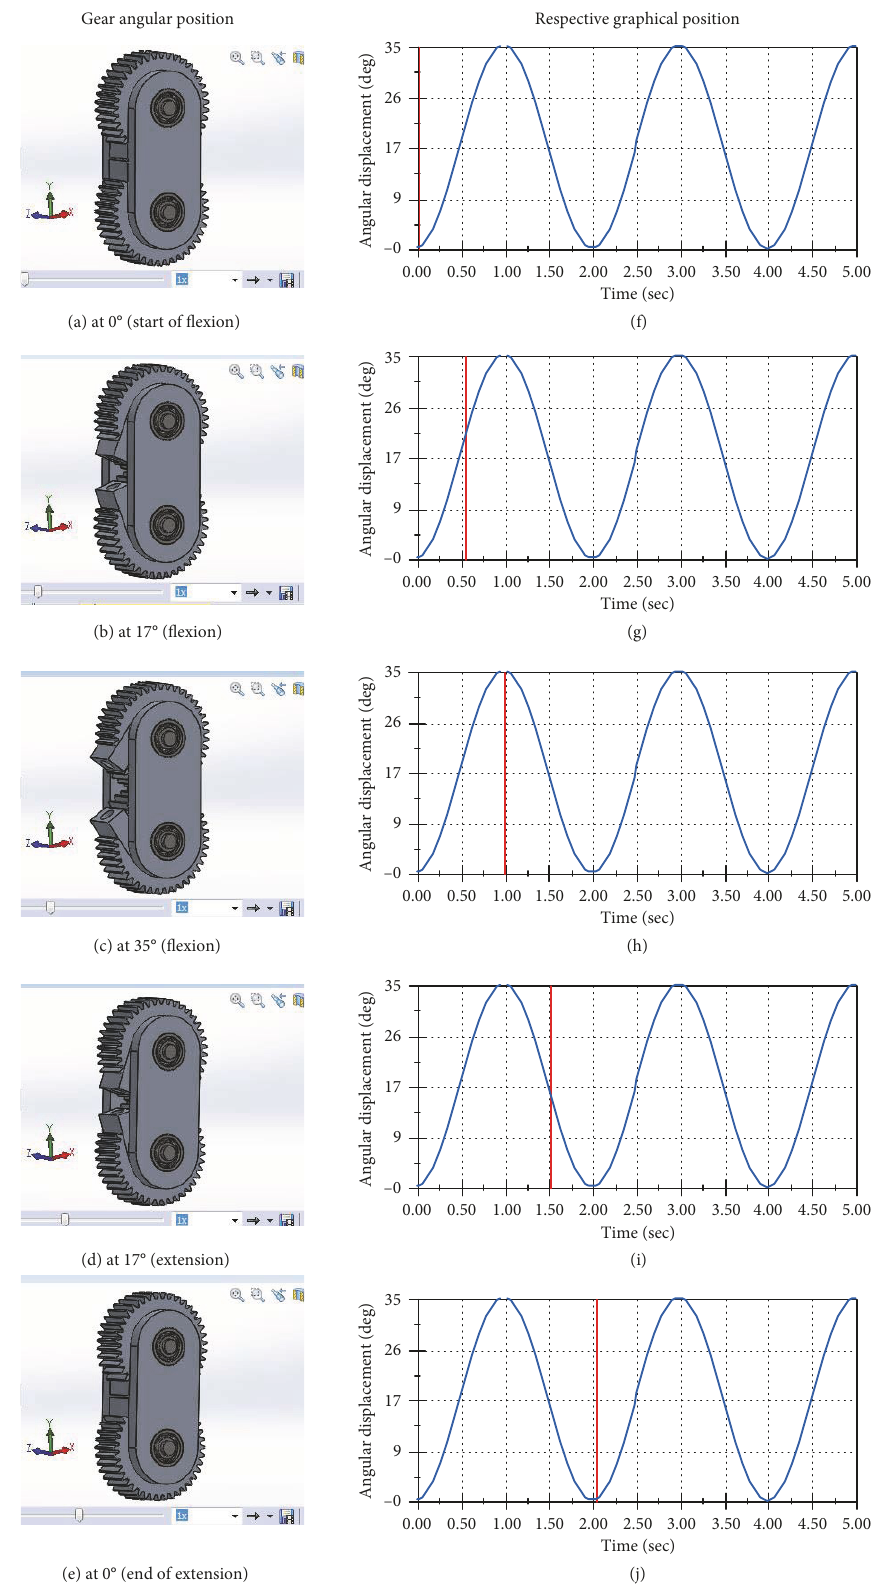
Figure 3: Angular position of gear at di ff erent phases of the gait